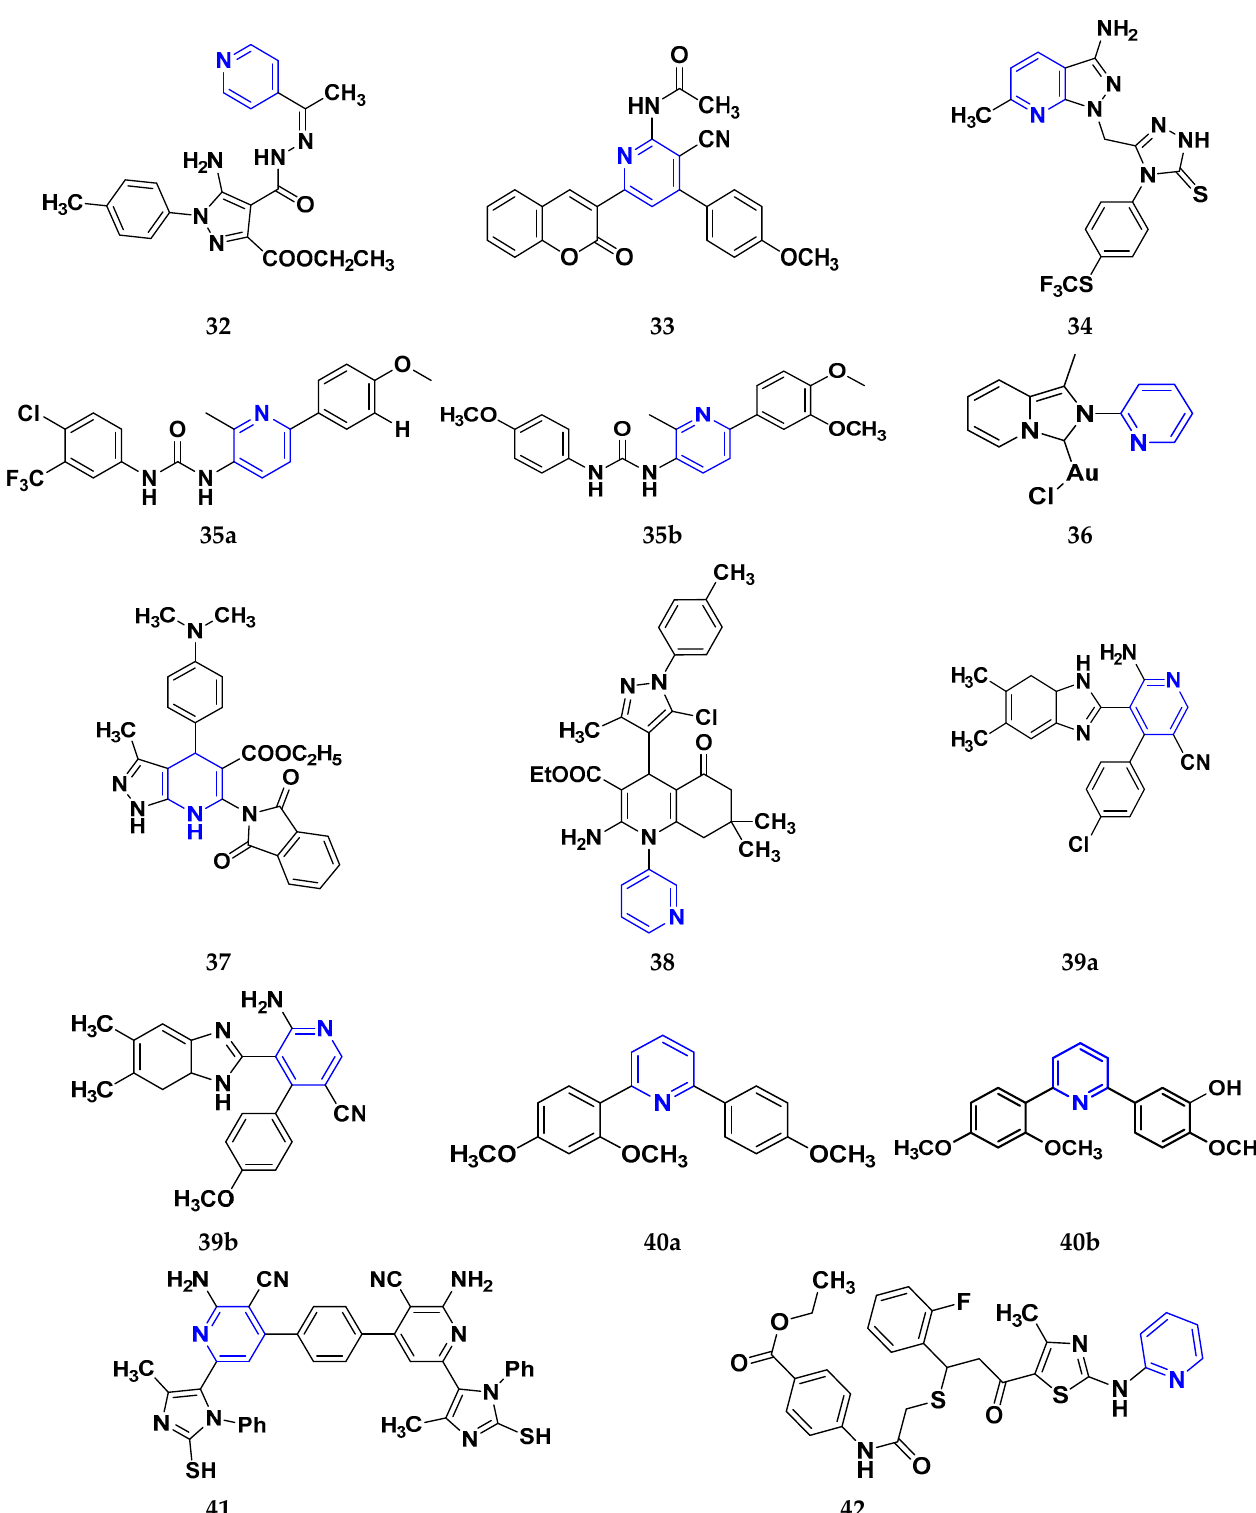
Figure 6. Pyridine derivatives ( 32 – 42 ) as anticancer agents.